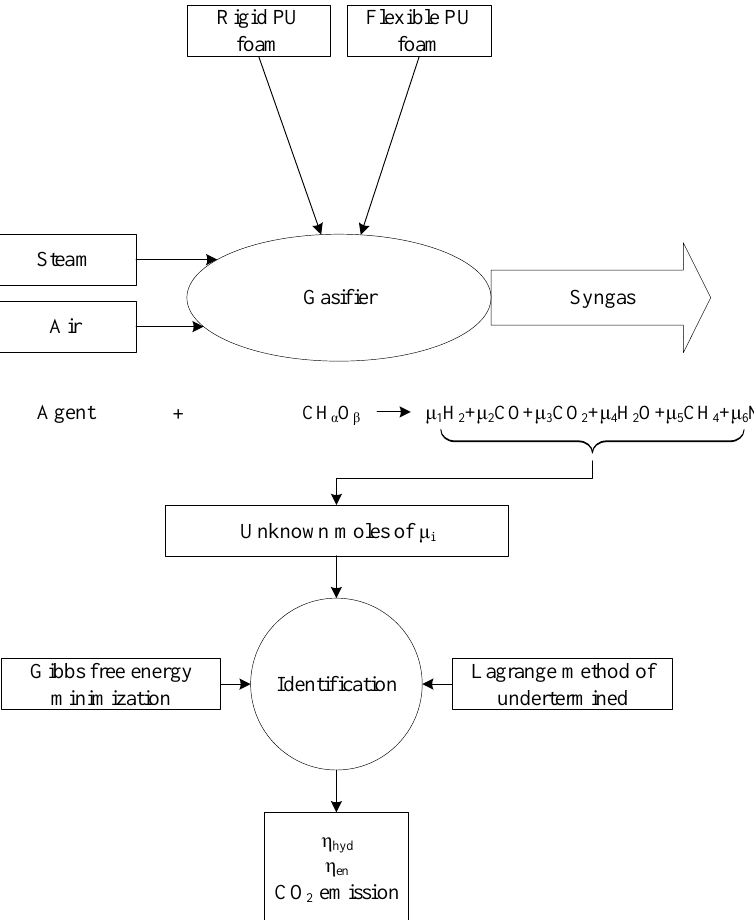
Figure 1. Schematic of the modeling procedure. Feedstock gasification results in a combustible syngas consisting H 2 , CO, CO 2 , CH 4 and N 2 (in the case of air gasification) in the presence of an oxygen carrier as gasifying agent. Steam and air are among the most relevant gasifying agents: steam gasification results in a significant hydrogen production while air gasification lead to lower CO 2 emission and has lower cost. Hence, both steam and air gasifying agents were considered for this study and their performance was compared in detail. As one of the main objectives of the present research work, waste flexible and rigid PU foams were selected as the feedstock types and their proficiencies were investigated in the gasification process. The feedstock is reacted in the gasifier reactor with the gasifying agent, comprising evaporated water after passing through a heat exchanger in the steam case and air passed through an air conditioner in air gasification. Steam and air gasification of waste flexible and rigid